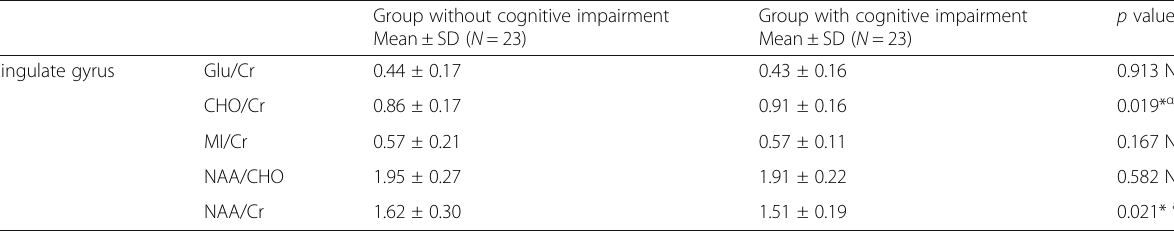
Table 3 Posterior cingulate gyrus metabolite ratios in both groups